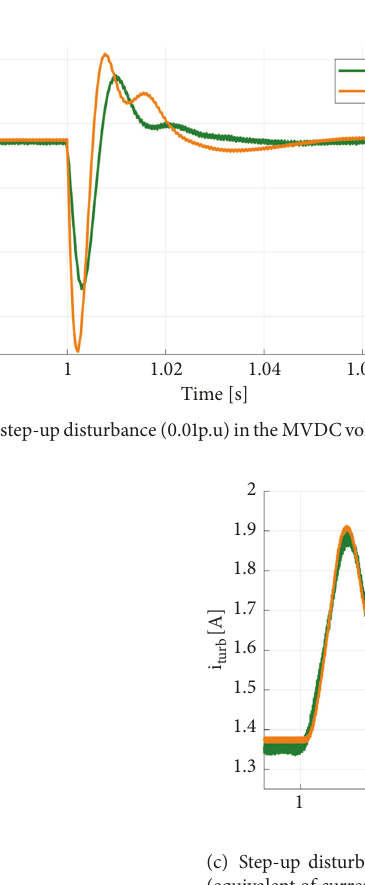
) when a step-up/-down disturbance is injected in system turb